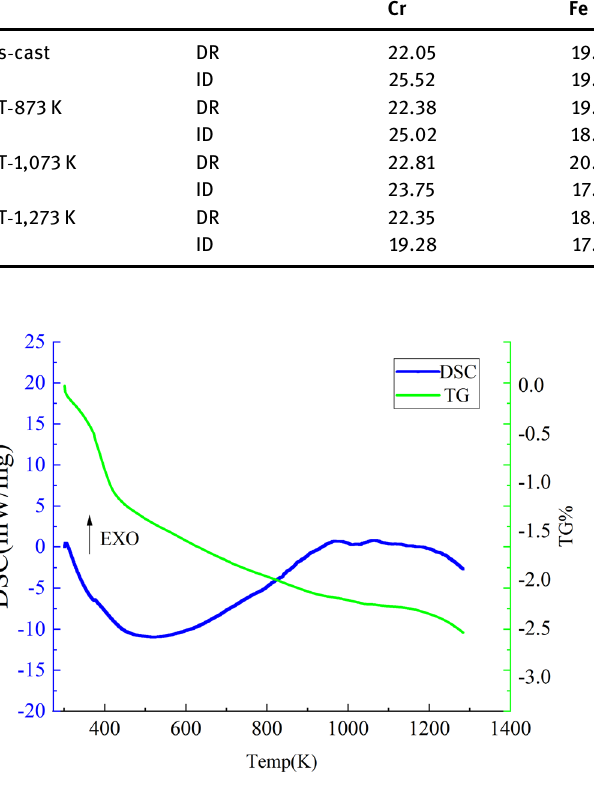
Figure 3: TG - DSC curves of FeCoCrNiMo highentropy alloy.